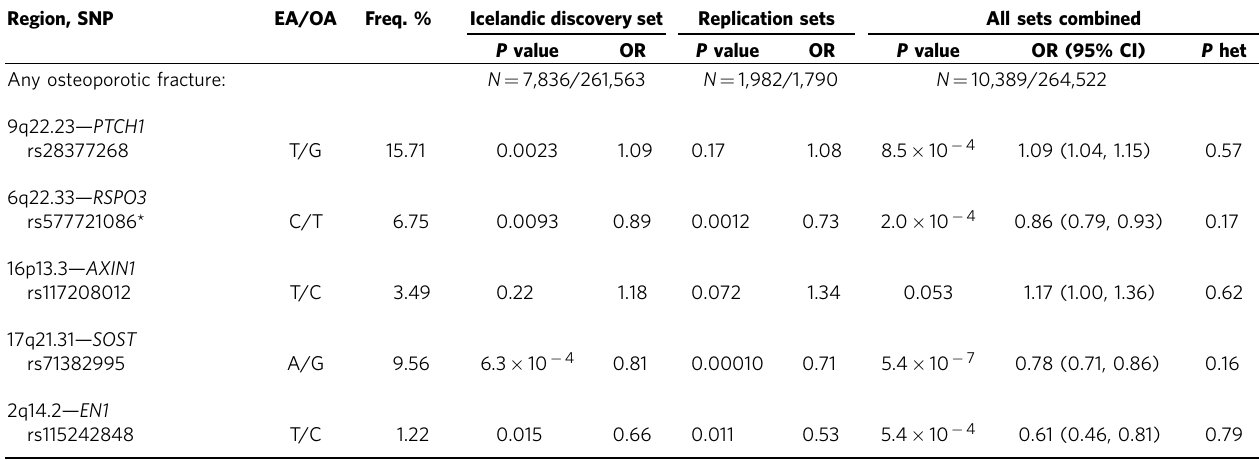
Table 3 | Association with osteoporotic fractures. Region, SNP EA/OA Freq. % Icelandic discovery set Replication sets Any osteoporotic